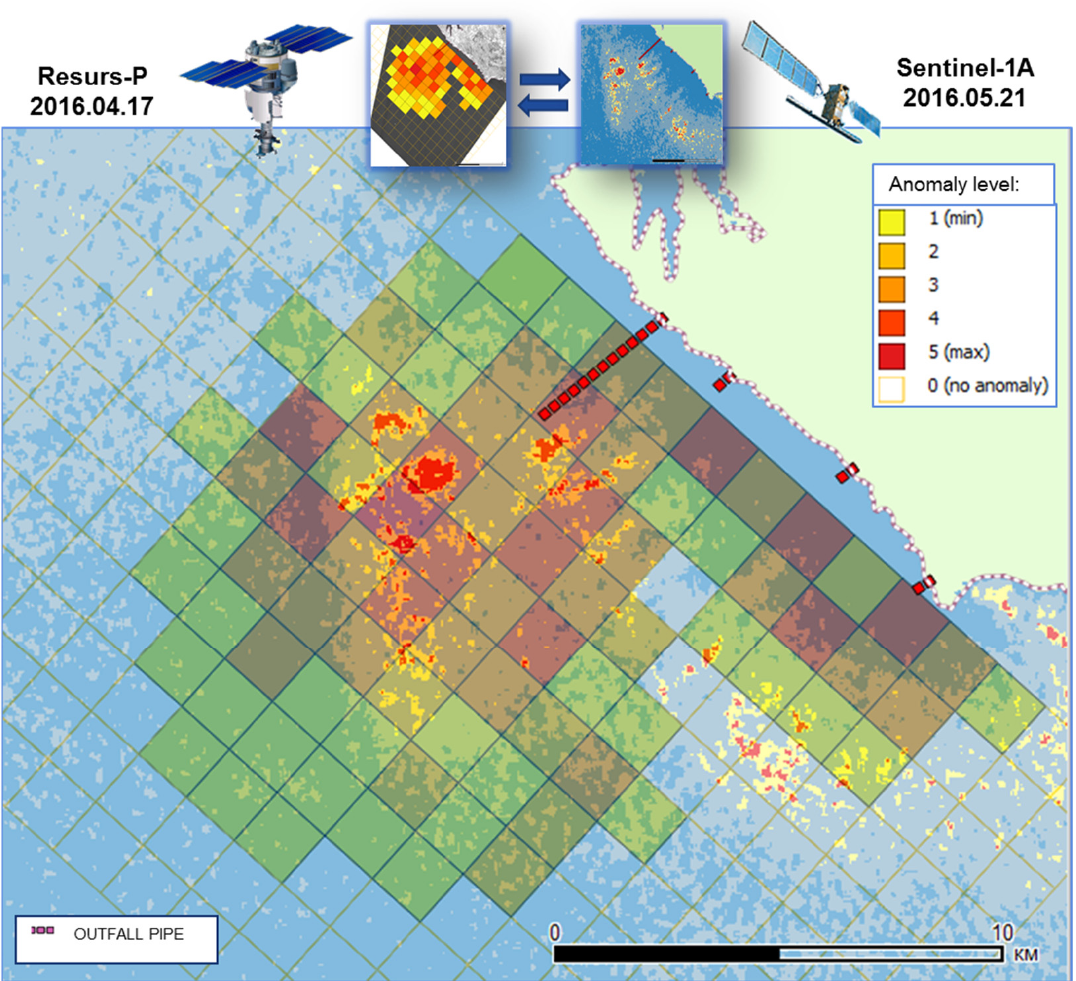
Figure 9. Example comparing the results of Sentinel-1A radar image processing and the results of the experiment on spatial spectral analysis of the optical Resurs-P image in the coastal waters of the city of Sevastopol.